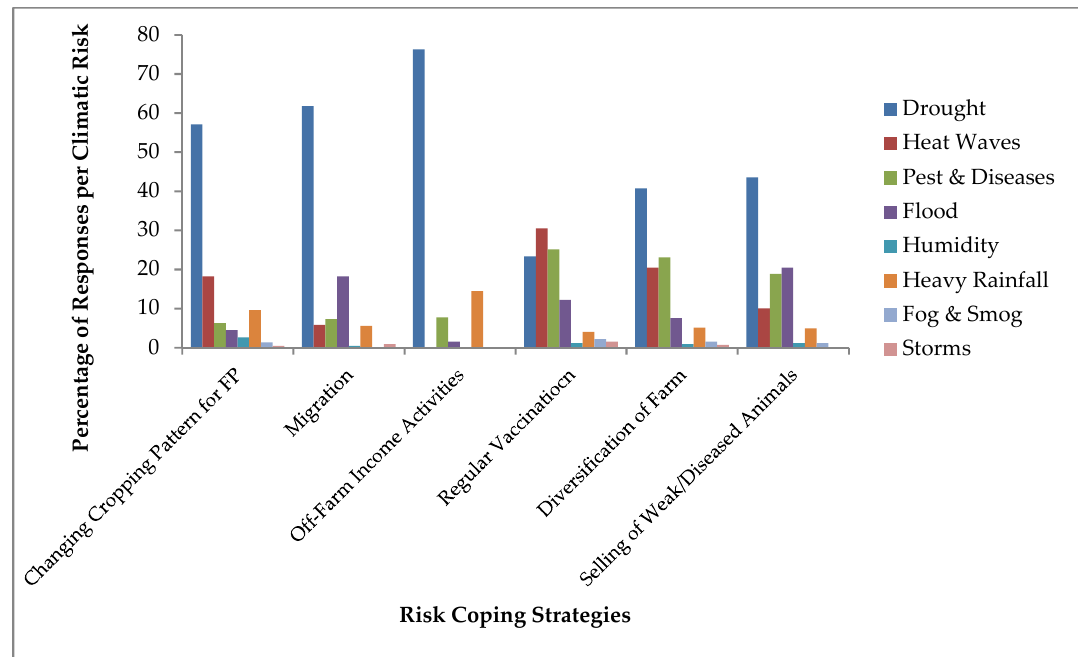
Figure 8. Risk coping adaptation strategies practiced by dairy farmers